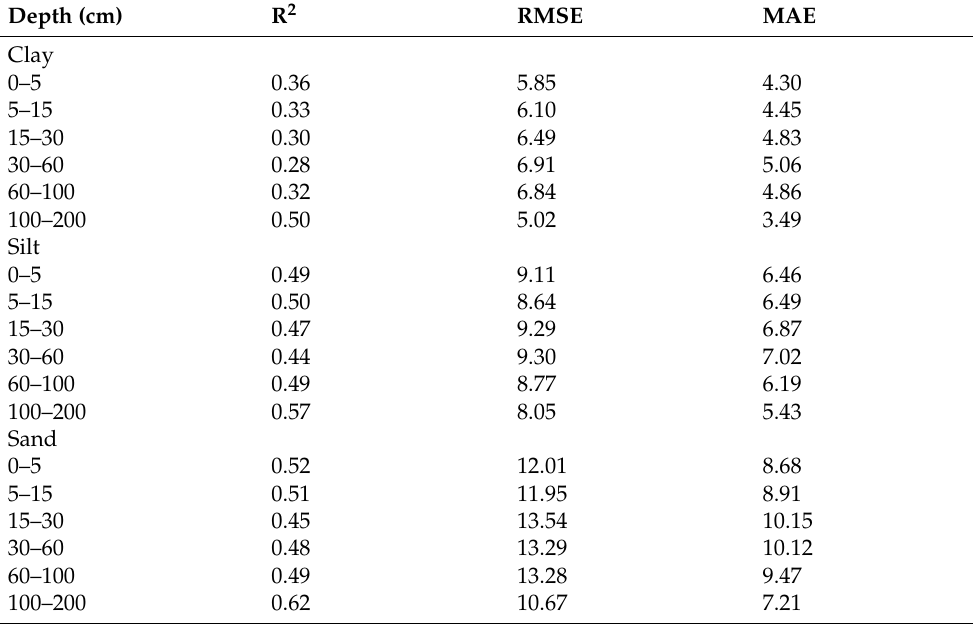
Table 3. Accuracy assessment of the soil particle size distribution